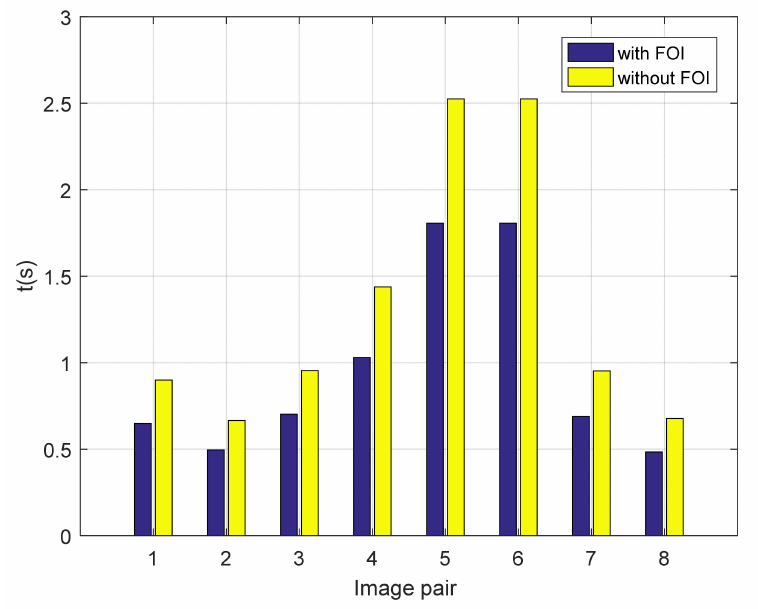
Figure 18. The running time used for extracting AWOG descriptors with or without the FOI on all experimental image pairs used in Section 5.1.1.